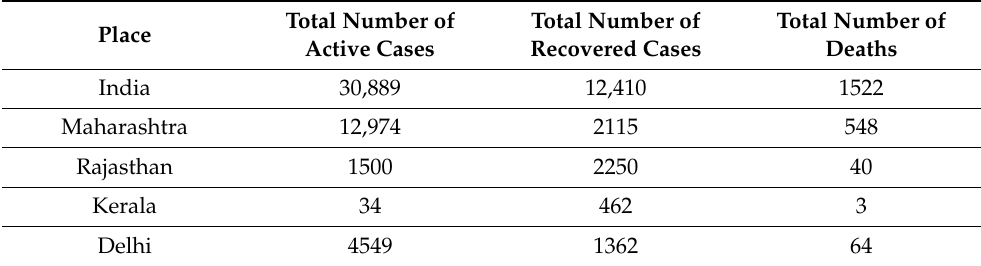
Table 2. Statistical information of the data.